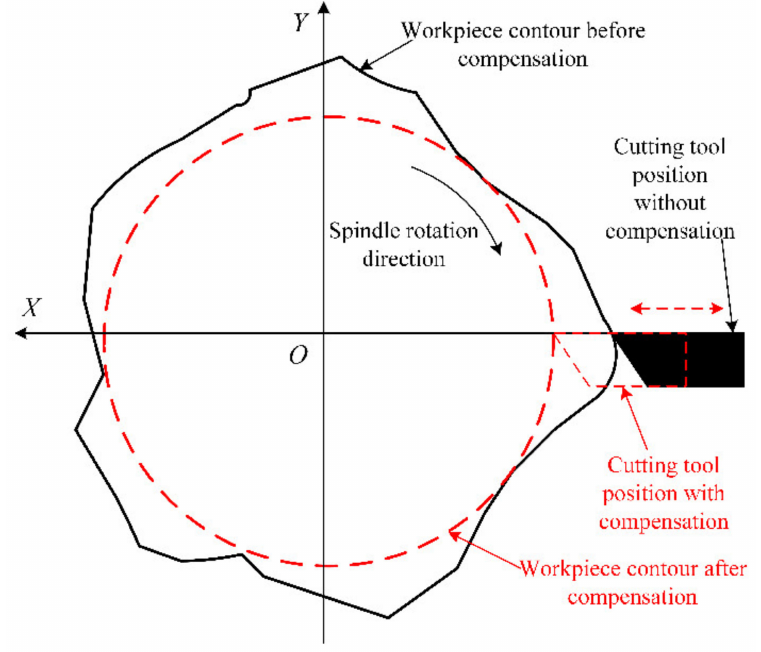
Figure 9. Tool path comparison before and after